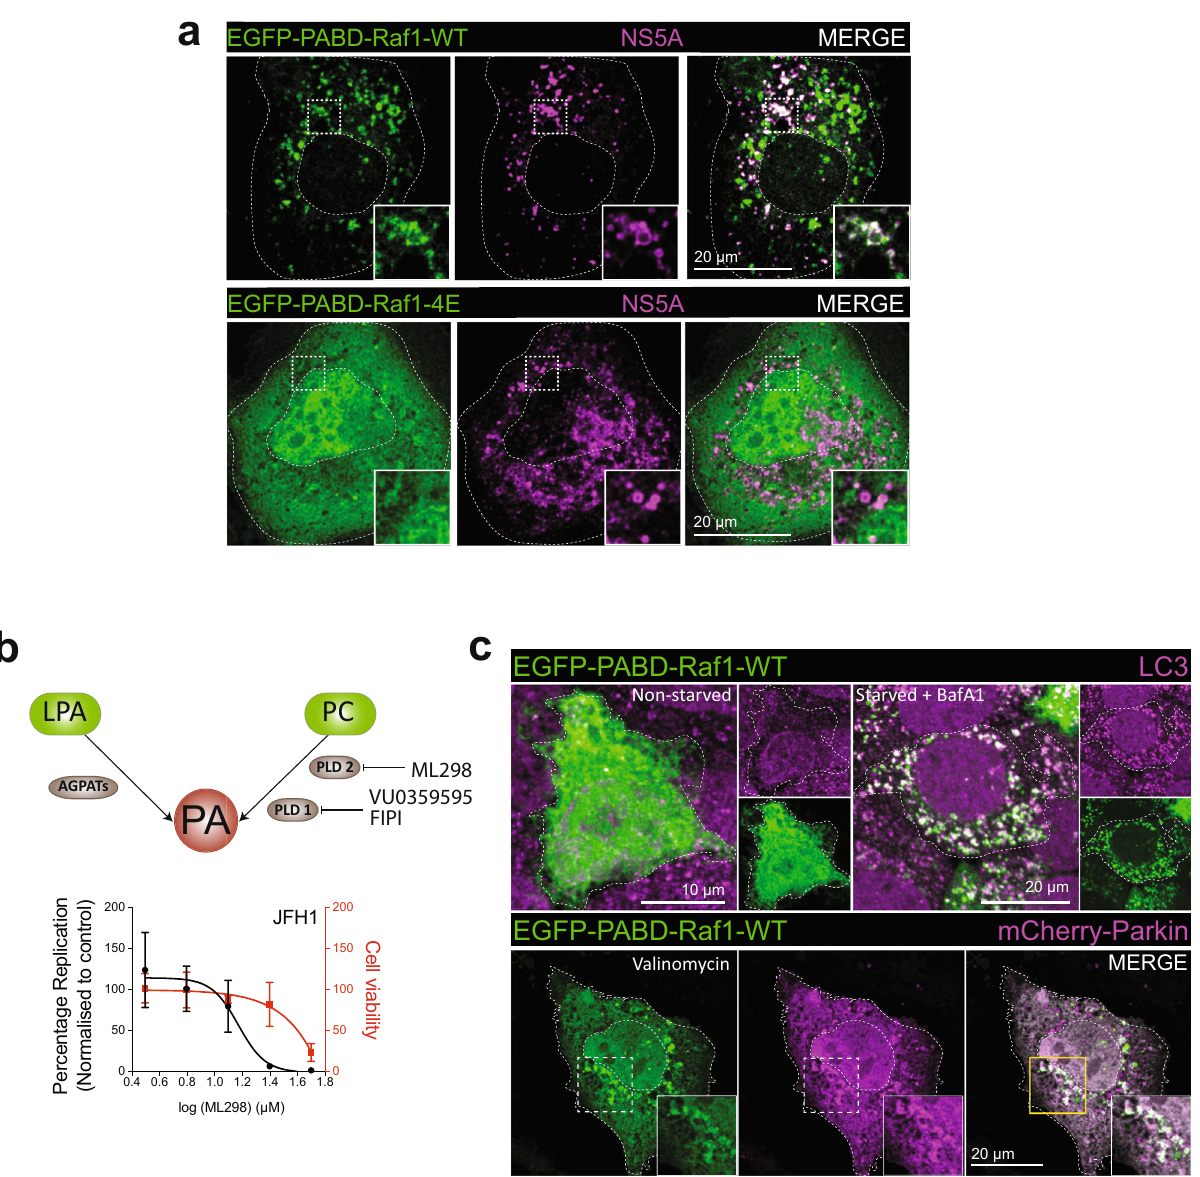
Fig. 4 PA accumulation on HCV DMVs and autophagy-related structures and role of alternative PA synthesis pathway for HCV replication. a PA accumulation at NS5A containing structures. Huh7-Lunet/T7 cells were transfected with a construct analogous to the one in Fig. 3a, but containing a mCherry insertion in lieu of EGFP, along with an EGFP-tagged wildtype (WT) or mutant (4E) PA sensor (construct pTM-EGFP-PABD-Raf1-WT or − 4E). Twenty-four hours later, EGFP-PABD and NS5A-mCherry were visualized by fl uorescence microscopy. White boxes indicate regions magni fi ed in the lower right of each panel. Two biologically independent experiments showed similar results. b Top panel: Alternate PA biosynthesis pathways via lysophosphatidic acid (LPA) or phosphatidylcholine (PC) catalyzed by AGPATs or PLDs, respectively. Bottom panel: Huh7-Lunet/T7 cells were electroporated with in vitro transcripts of a subgenomic HCV reporter replicon encoding the fi re fl y luciferase. Four hours after transfection, different concentrations of PA synthesis inhibitors were added to the cells and luciferase activities were analyzed 48 h after electroporation. Graph shows average and SD from three independent experiments. Cell viability determined by CellTiter-Glo luminescent assay is indicated with the red line. Data are represented as mean ± SD from three biologically independent experiments. c PA recruitment to autophagy-related structures in selective and non- selective autophagy. Top panel: Huh7-derived cells expressing EGFP-PABD-Raf-1 were incubated in growth medium (top left panels) or in serum-free medium with 200 nM BafA1 (top right panels) for 3 h. Cells were fi xed and stained with a LC3 speci fi c antibody. Bottom panel: For selective autophagy, mCherry-tagged Parkin was co-expressed with EGFP-PABD-Raf1, followed by incubation with 10 µ M Valinomycin to induce mitophagy. Cells were fi xed after 3 h, and EGFP-PABD and mCherry-Parkin were visualized by fl uorescence microscopy. Images in panels e and g are maximum intensity projections. Two biologically independent experiments showed similar